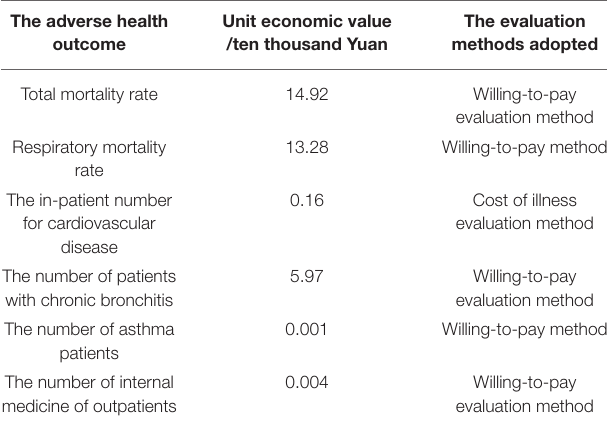
TABLE 7 | Economic value and evaluation method of each adverse health outcome in Z City (Unit: ten thousand dollars). The adverse health